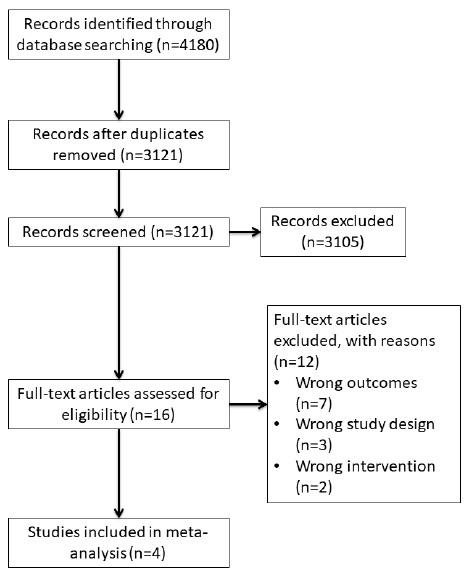
Figure 1. Flowchart of the review ( n is the number of records /